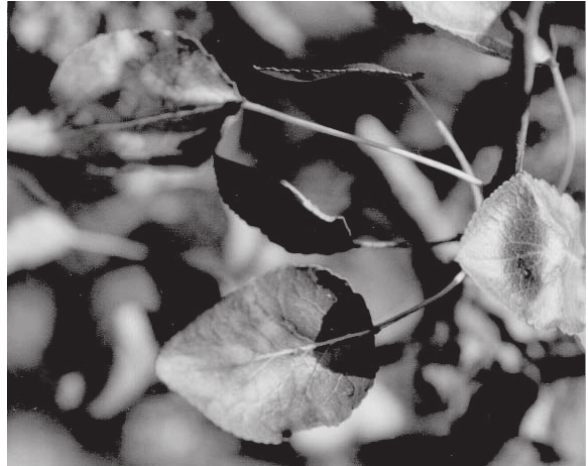
Fig 1. Leaves of Pyrus mamorensis infected with Pesta- lotia subcuticularis .